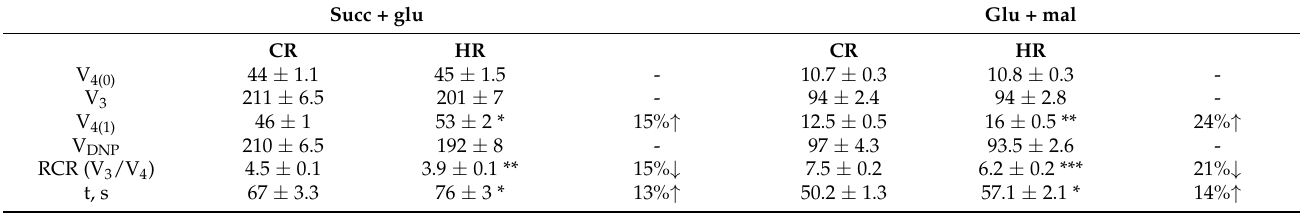
Table 3. Respiration parameters of heart mitochondria of control and hyperthyroid